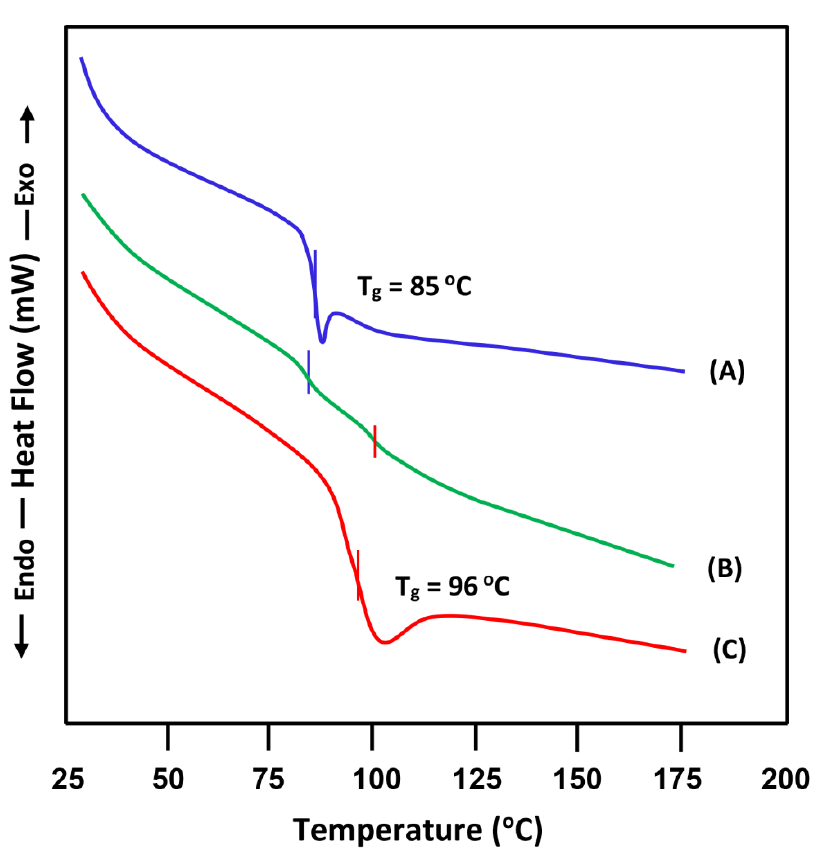
Figure 2. DSC thermograms of: (A) pure PVC; (B) PVC/PS-50 and (C) pure PS.